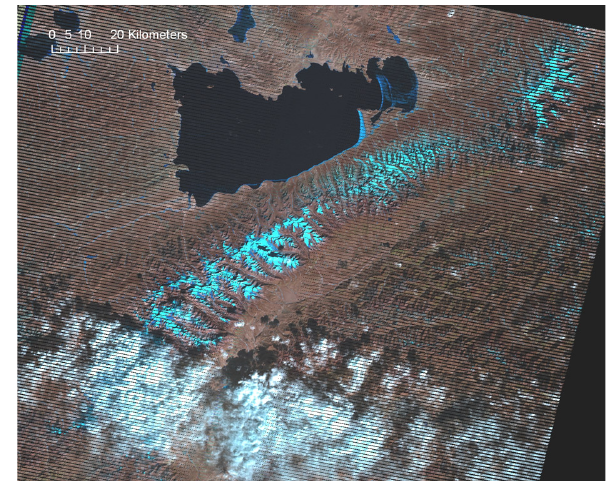
Fig. 3. Typical situation of a Landsat scene (ETM+ SLC-off from 18 January 2006): Part of the study area is suitable for glacier map- ping, while seasonal snow hampers correct mapping in the NE re- gion, and clouds covers the SW region. The region of highest inter- est in the center is not affected by scanline errors of the SLC